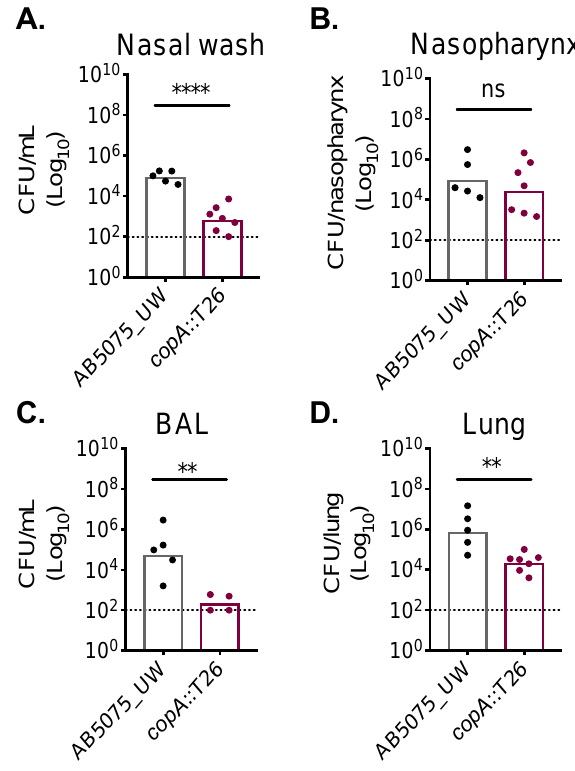
Figure 5. CopA aids in A. baumannii murine colonisation. Outbred Swiss mice (5-week-old females), were intranasally challenged with 2 × 10 8 colony-forming units (CFUs) of strains AB5075_UW (black dots) or its copA ::T26 derivative (burgundy dots). After 24 h, mice were euthanised and the A. baumannii cells were enumerated in ( A ) the nasal wash, ( B ) the nasopharynx, ( C ) the bronchoalveolar lavage (BAL), and ( D ) the lungs. The data represent the geometric mean with the dotted line indicating the limit of detection. Statistical analyses were performed with a Student’s t -test (ns = not significant, ** p < 0.01; **** p < 0.0001).